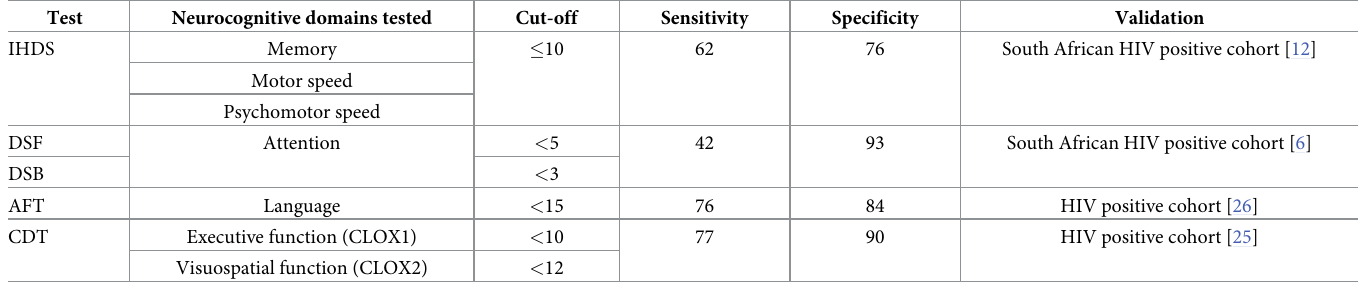
Table 1. Profile of neuropsychological tests used: Psychometric profile of tests. Test Neurocognitive domains